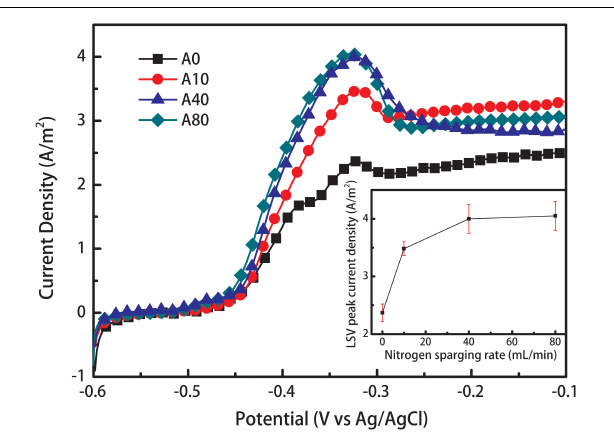
FIGURE 3 | Anode resistance of the anodes enriched with different nitrogen sparging rates. Anode resistance was obtained from the Nyquist plots ( Supplementary Figure S2 ) fitted using a two time-constant model, R s (R ct Q 1 )(R d Q 2 ), in which R s represents the anode resistance, R ct represents the charge transfer resistance, R d represents the diffusion resistance, and Q 1 and Q 2 are the constant phase angle